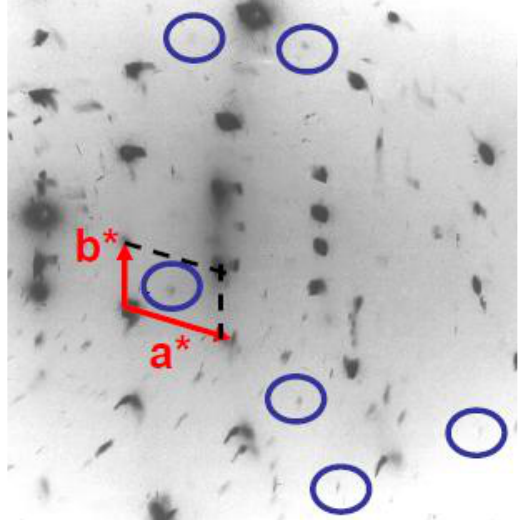
Figure 10. X-ray diffuse scattering pattern from (TMTTF) state showing inside the blue circles very weak (1/2, 1/2, ?) superlattice spots. The (a*, b*) unit cell is shown (original data of the study reported in